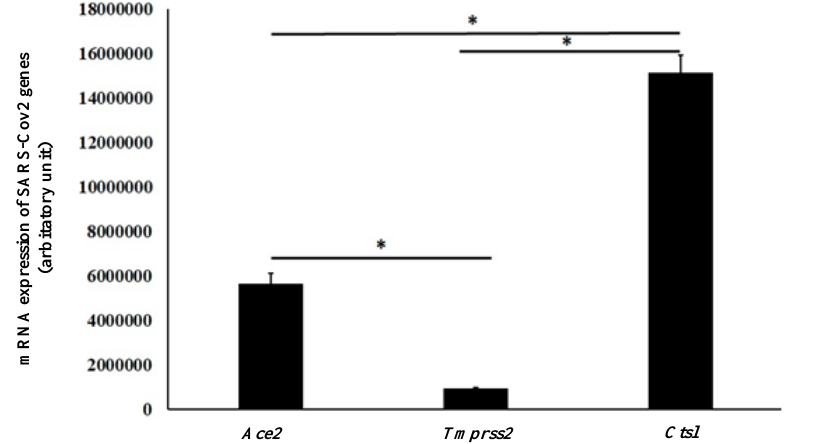
Figure 3. Relative mRNA expression of SARS-CoV-2 entry genes in the mouse lungs. * indicates a statistical alteration ( p <0.05, one-way ANOVA